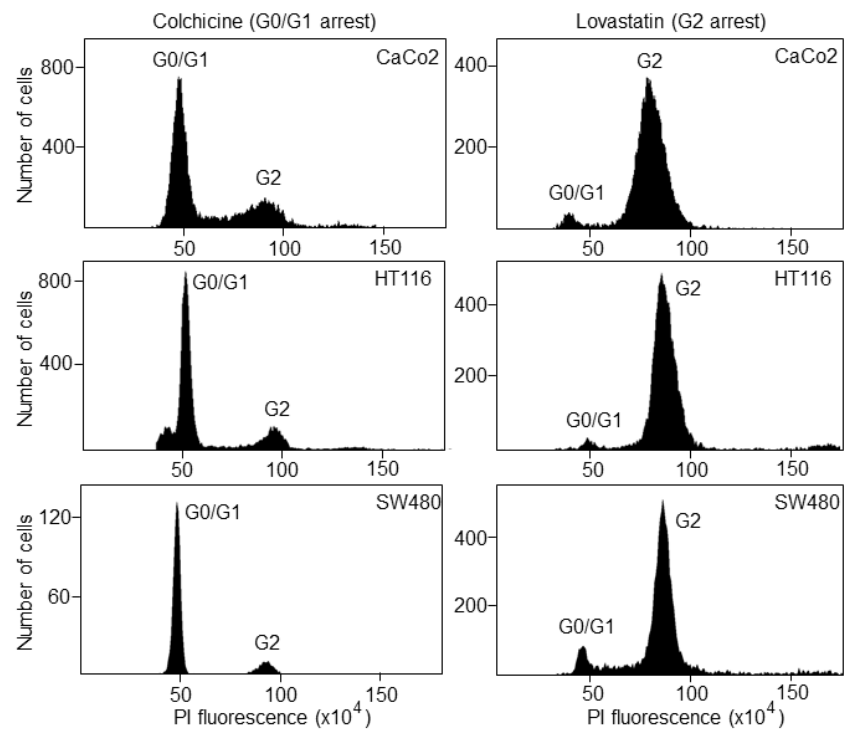
Figure 2. Cell-cycle synchronization of colorectal cancer cell lines. CaCo2, HCT116 and SW480 cells were treated with lovastatin or colchicine and then incubated with propidium iodide for cell-cycle analysis by FACS. G0/G1 and G2 represent the cell cycle phases before and after DNA synthesis, respectively.